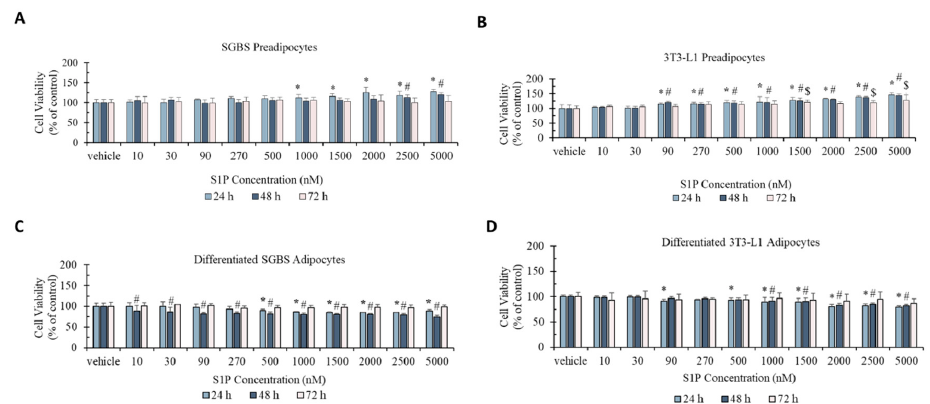
Figure 1. Cell viability (% of control) of preadipocyte SGBS cells ( A ), preadipocyte 3T3-L1 cells ( B ), differentiated adipocyte SGBS cells ( C ) and differentiated adipocyte 3T3-L1 cells ( D ) under sphingosine-1-phosphate (S1P) treatment (10–5000 nm) for 24 h, 48 h, and 72 h, respectively. Cells